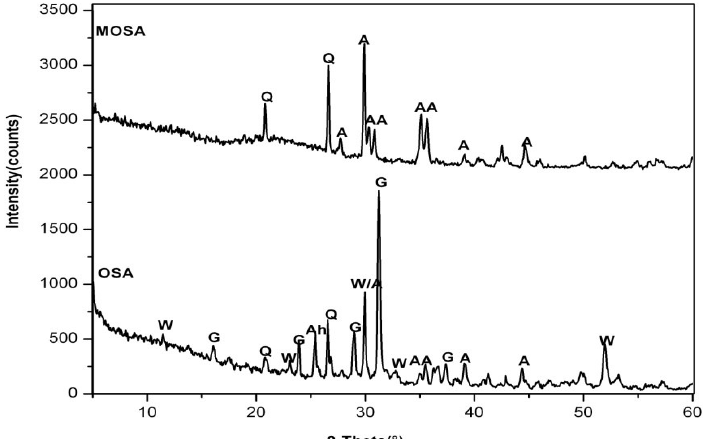
Figure 1. XRD patterns of oil shale ash (OSA) and modified oil shale ash (MOSA). Q: Quartz, W: Wollastonite, A: Augite, G: Gehlenite, Ah: